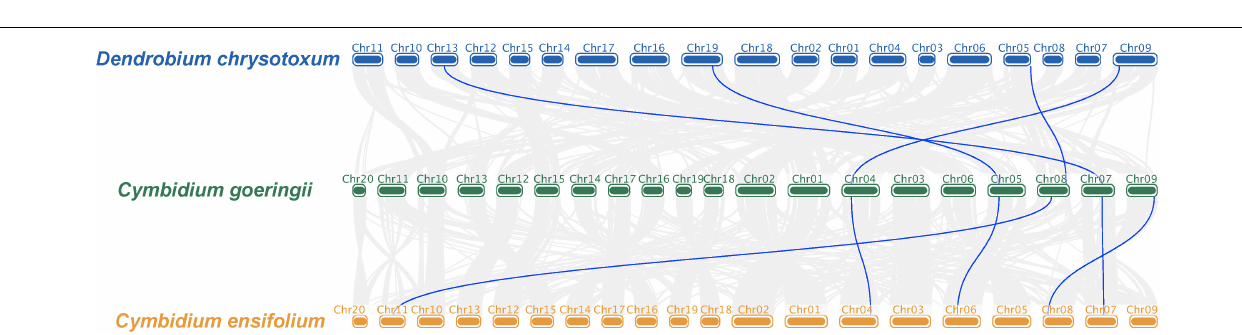
FIGURE 2 | The collinearity of KNOX genes between D. chrysotoxum and C. goeringii , C. goeringii and C. ensifolium. The collinear analysis demonstrated a one-to-one correspondence among all KNOX genes in three